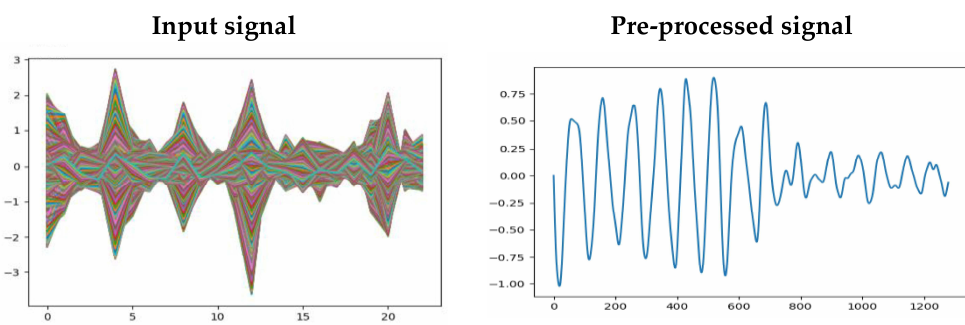
Figure 3. Pre-processed signals with artifacts and after elimination of input signals.